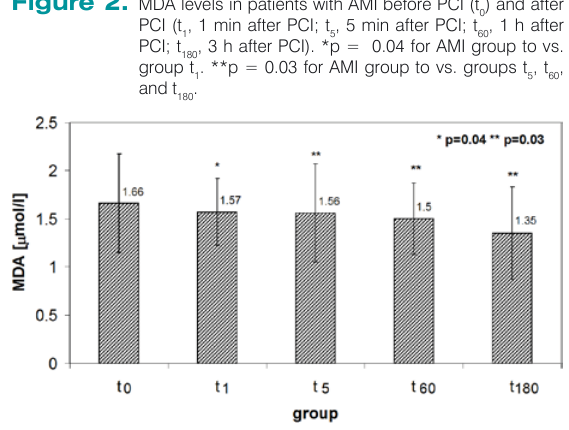
). *p = 0.01 for control group vs. AMI group before PCI (t 0 (t ). 0